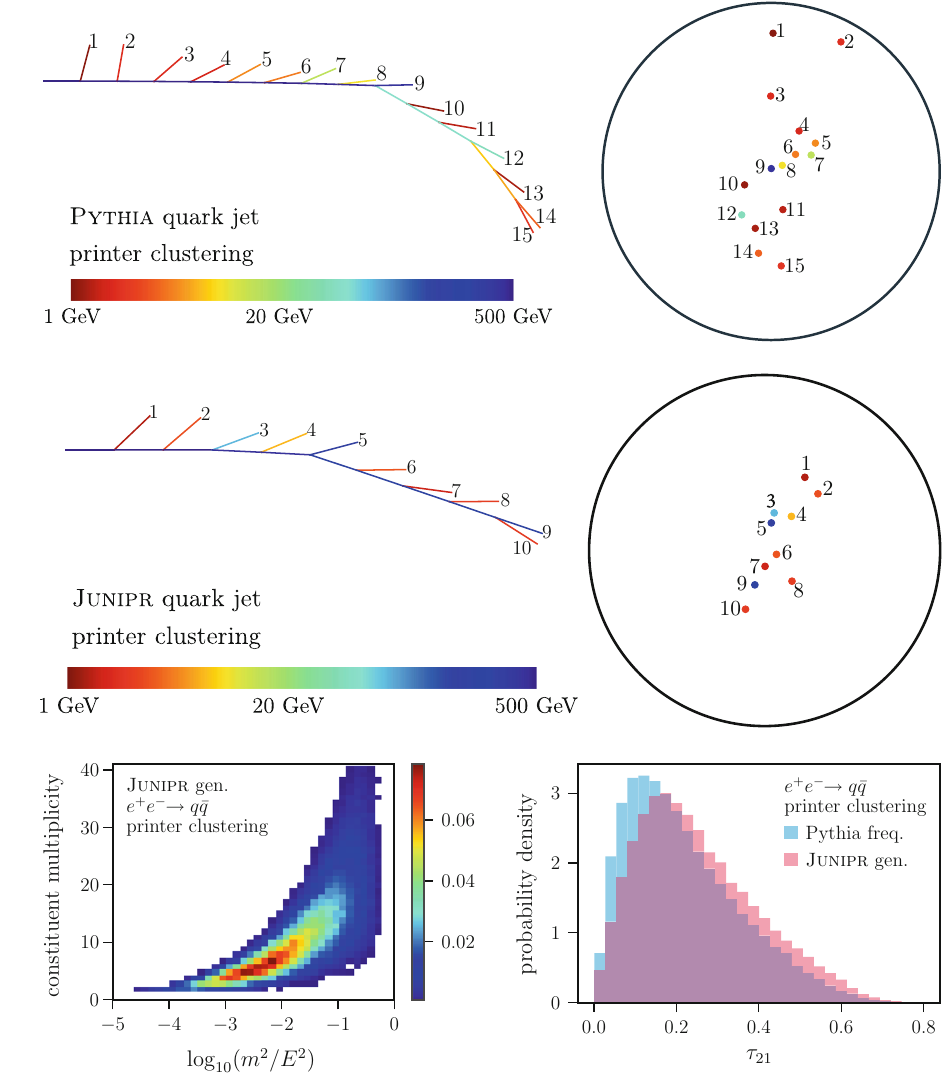
Fig. 22 (Left) 2-dimensional distribution with respect to jet mass and constituent multiplicity, calculated by sampling jets directly from P printer , an instance of Junipr trained on jets clustered with the printer algorithm. (Right) 2-subjettiness ratio observable distribution generated using P printer and compared to